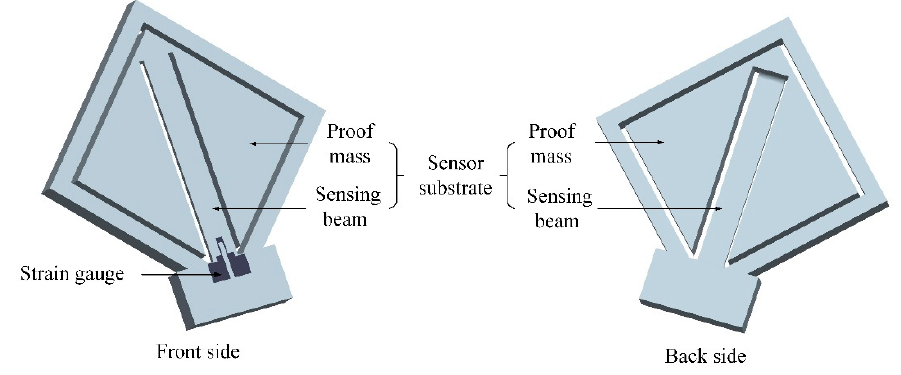
Figure 1. Diagrammatic sketch of the proposed accelerometer.